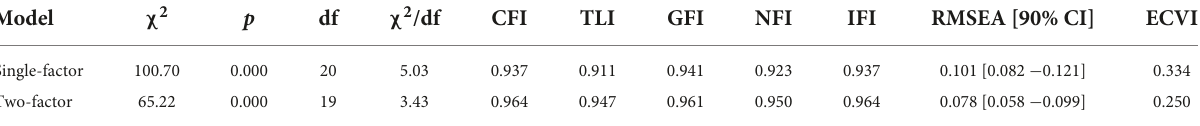
TABLE 2 Fit indices in confirmatory factor analysis for a single-factor and a